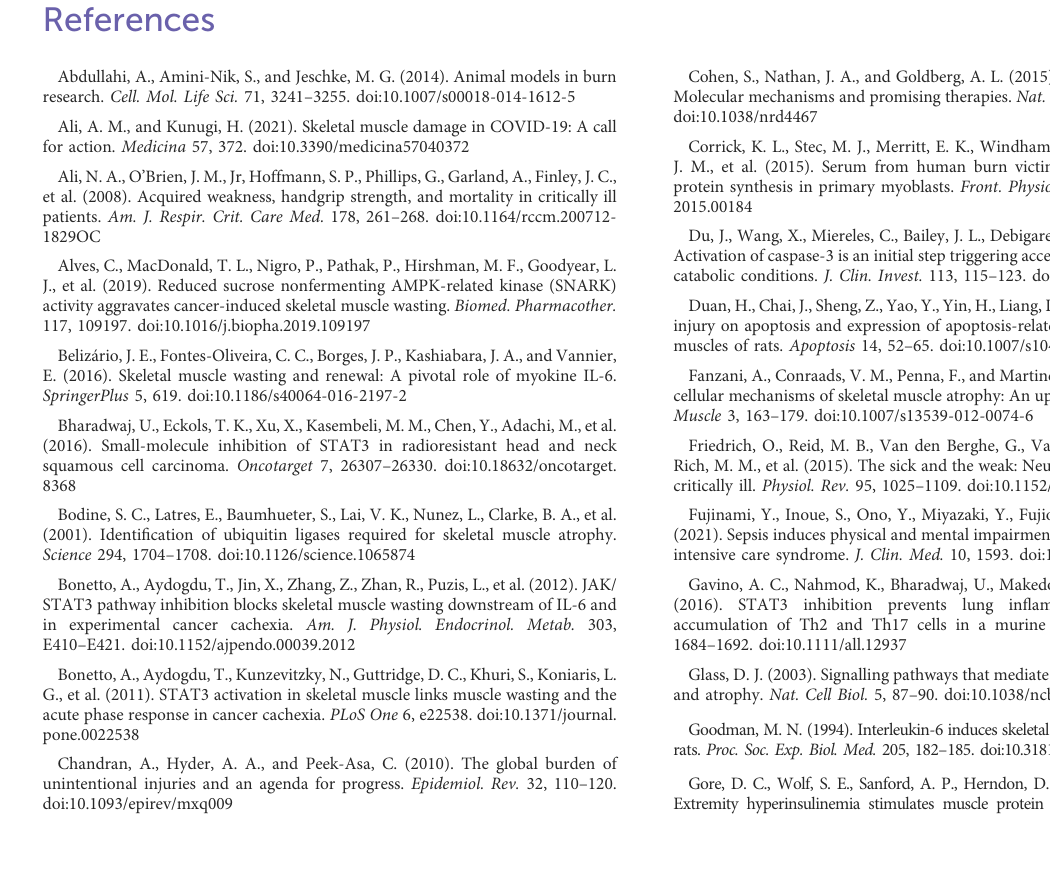
FIG. (https://medical fi g.medicaleducation.co.jp/) for help in generating Figure